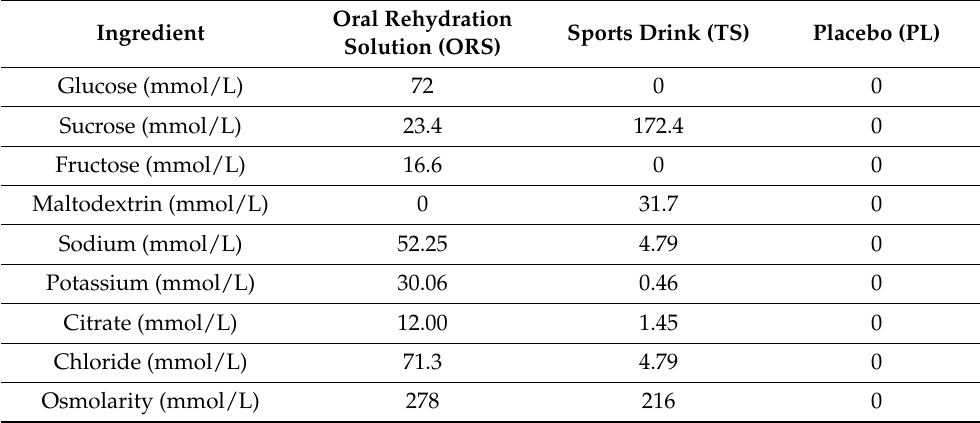
electrolyte content (g/L and mmol/L), and flavoring (g/L) for each drink: Oral rehydration solution (ORS), placebo (PL), traditional sports drink (TS) prepared for this